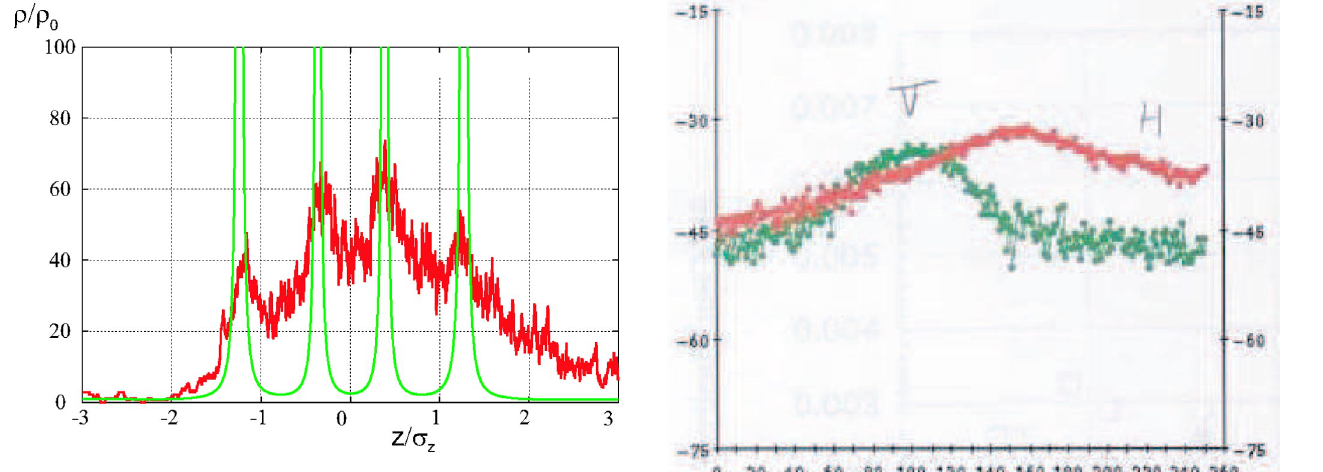
FIG. 64. (Color) Vertical (green) and horizontal (red) tune spec- trum detected at the KEKB LER in 2000 or 2001, with solenoids off; the different width of the vertical spectrum as compared with Fig. 65 indicates significant incoherent tune spread [107].